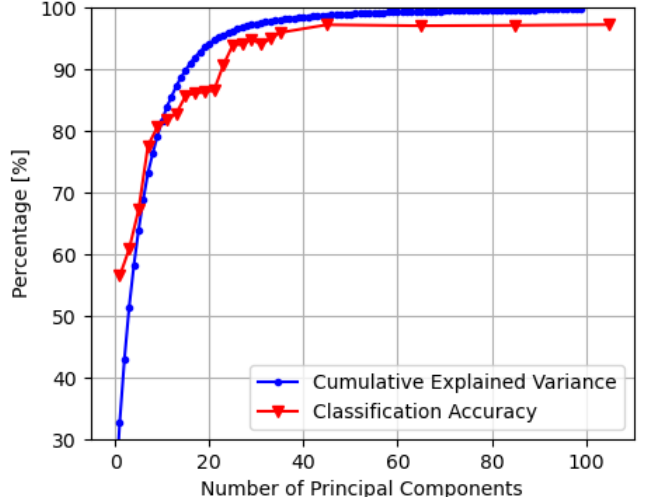
Figure 8. Classification accuracy of SVM model and cumulative explained variance with the number of principal components.